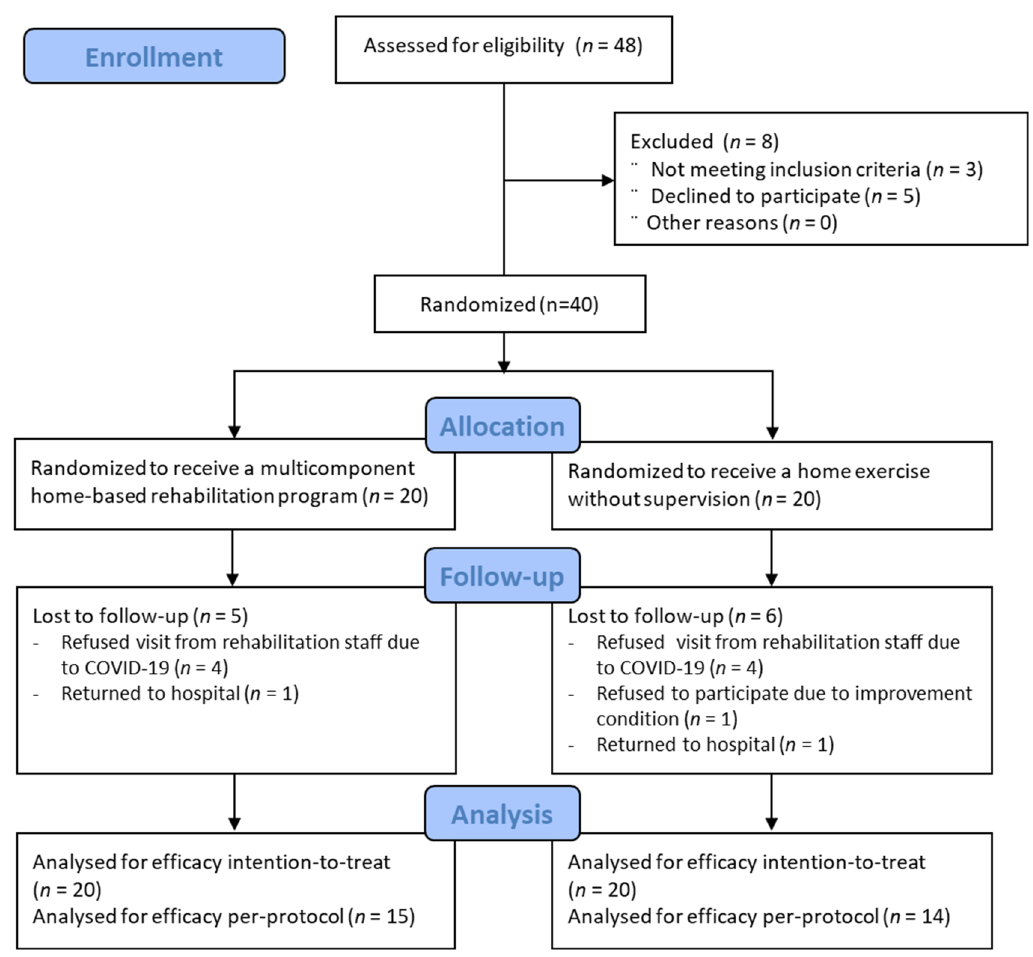
Figure 1. Flowchart of the study.